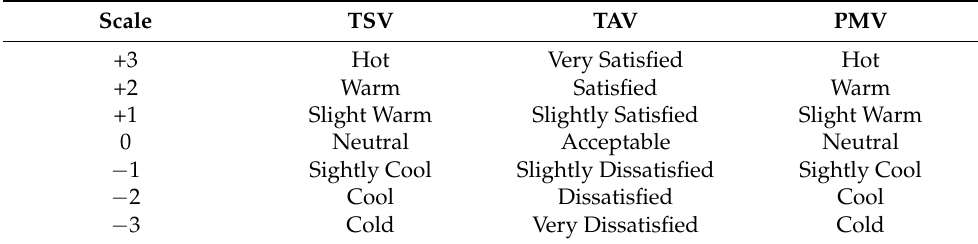
Table 4. Thermal sensation scale of TSV, TAV and